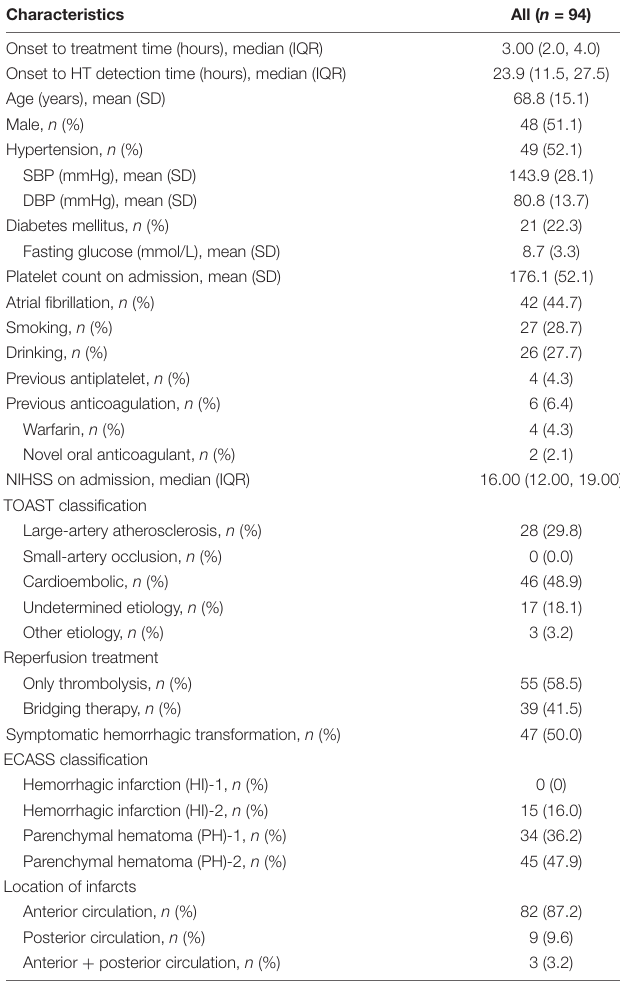
TOAST classification, Trial of Org 10172 in Acute Stroke Treatment classification; SBP, systolic blood pressure; DBP, diastolic blood pressure; HT, hemorrhagic